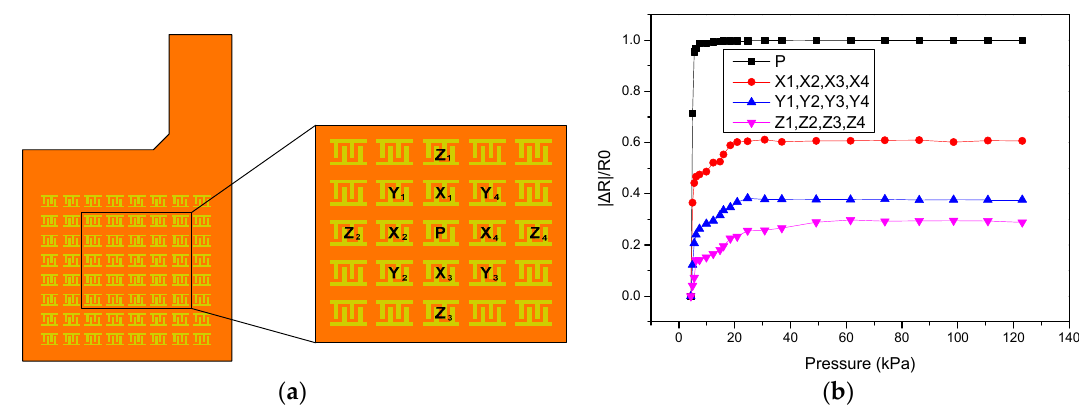
Figure 9. ( a ) Schematic of the proposed sensing array for the crosstalk study; ( b ) Measured resistance variation of the proposed sensing array.